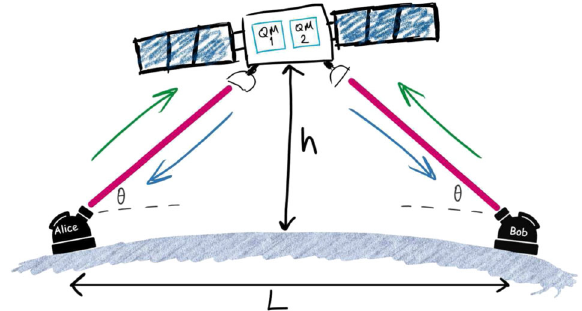
Fig. 3 MA-QKD protocol, following 32,33 , in the geometry of 23,75 . Green (blue) arrows show the uplink (downlink) protocol. Alice and Bob both have standard BB84 encoders. QM quantum memory, θ elevation, h orbital height, L total ground communication distance.